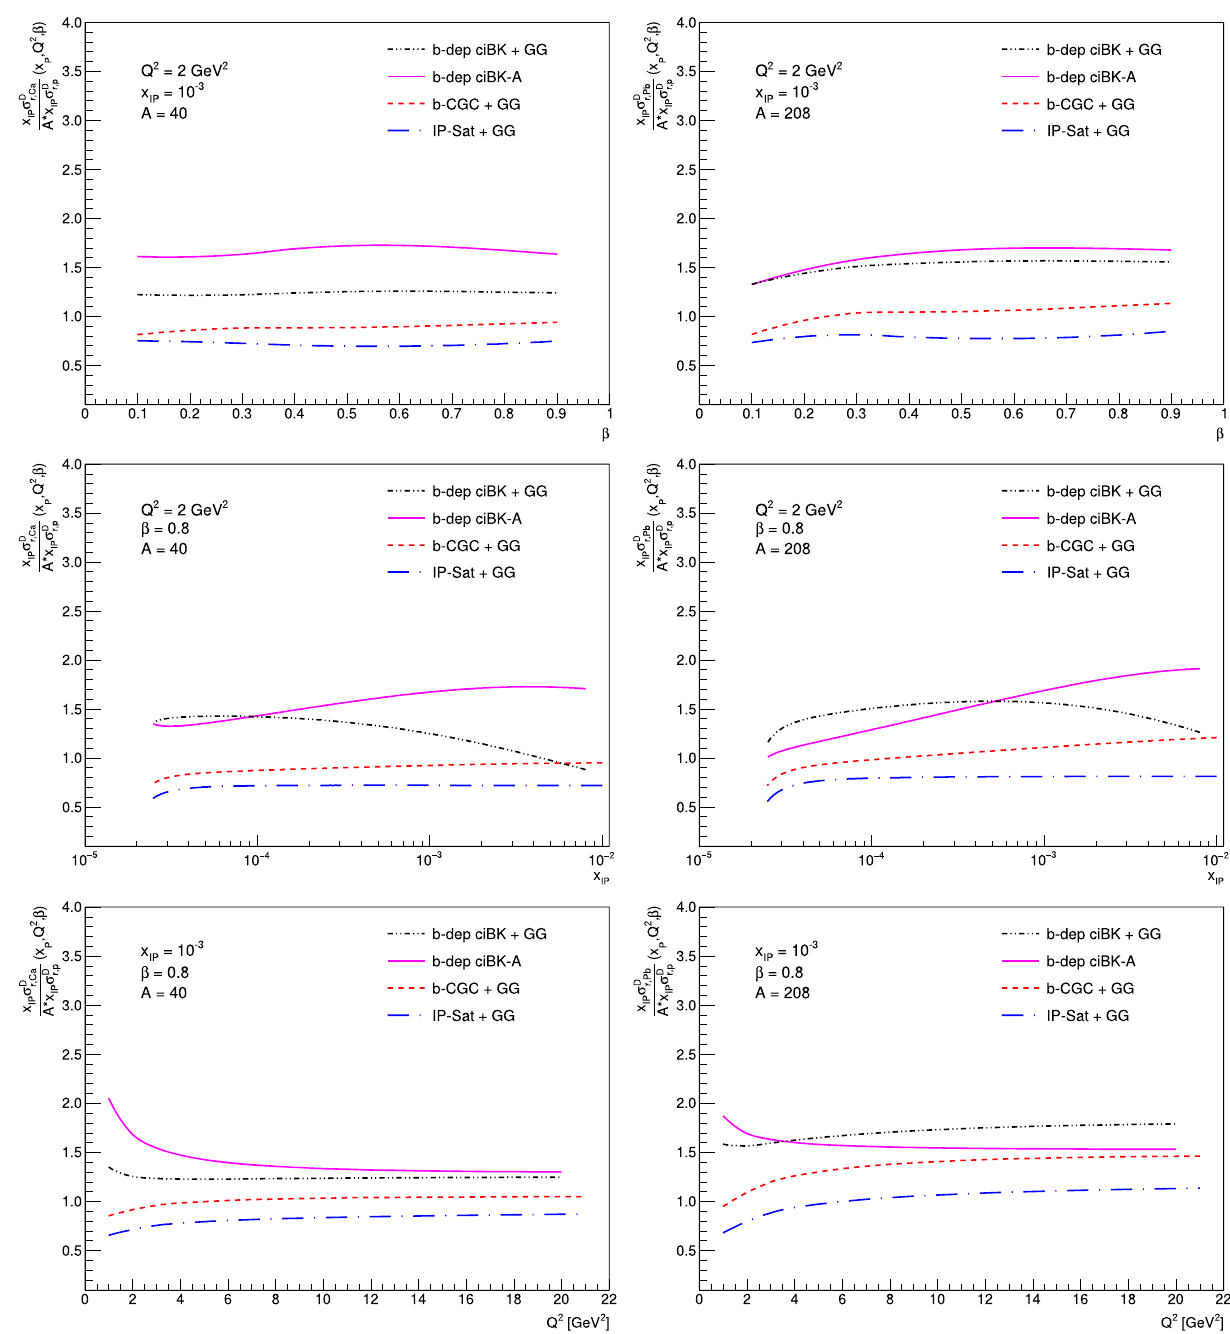
Fig. 8 Predictions for the β (upper panels), x IP (middle panels) and Q 2 (lower panels) dependencies of the ratio σ D ( 3 ), A r ( x IP ,β, Q 2 )/ A · ( x ,β, Q 2 ) for A = 40 (left panels) and A = 208 (right panels) considering the different models for the dipole-nucleus scattering σ D ( 3 ), p IP r